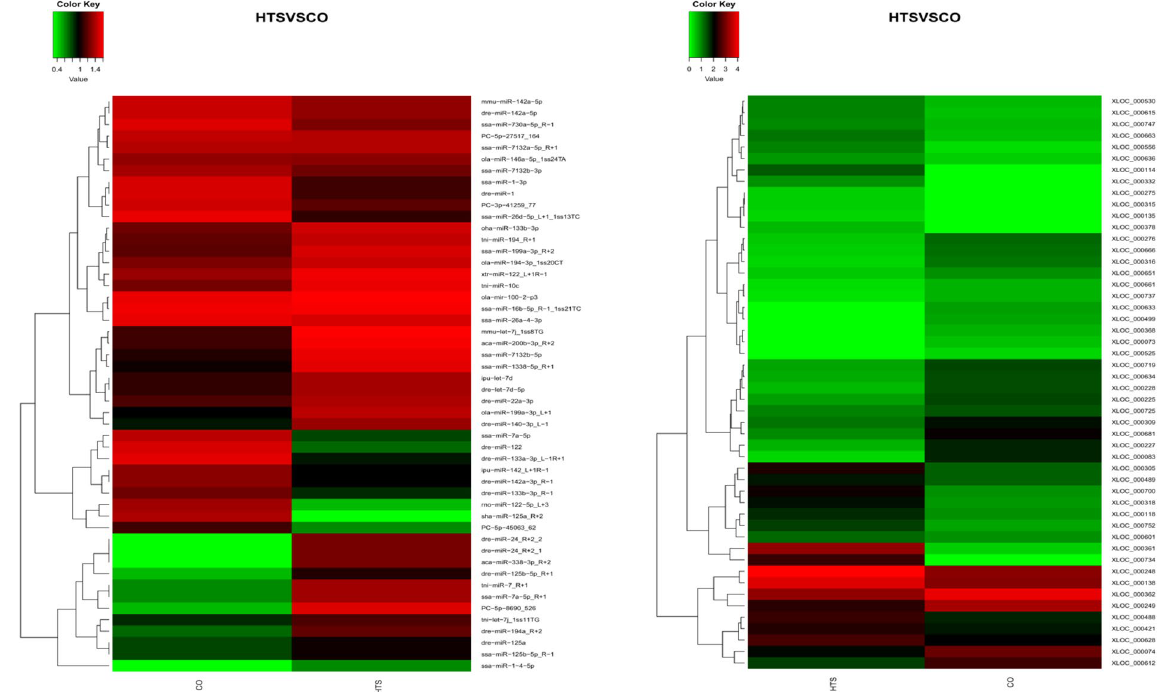
Figure 3. Hierarchical clustering of differentially expressed (DE) miRNAs and DE mRNAs between control (CO) and 37.5 °C heat-treated (HTS) groups. All the DE miRNAs are shown in the miRNA heat map, but only the top 60 DE mRNAs are shown in the mRNA heat map.